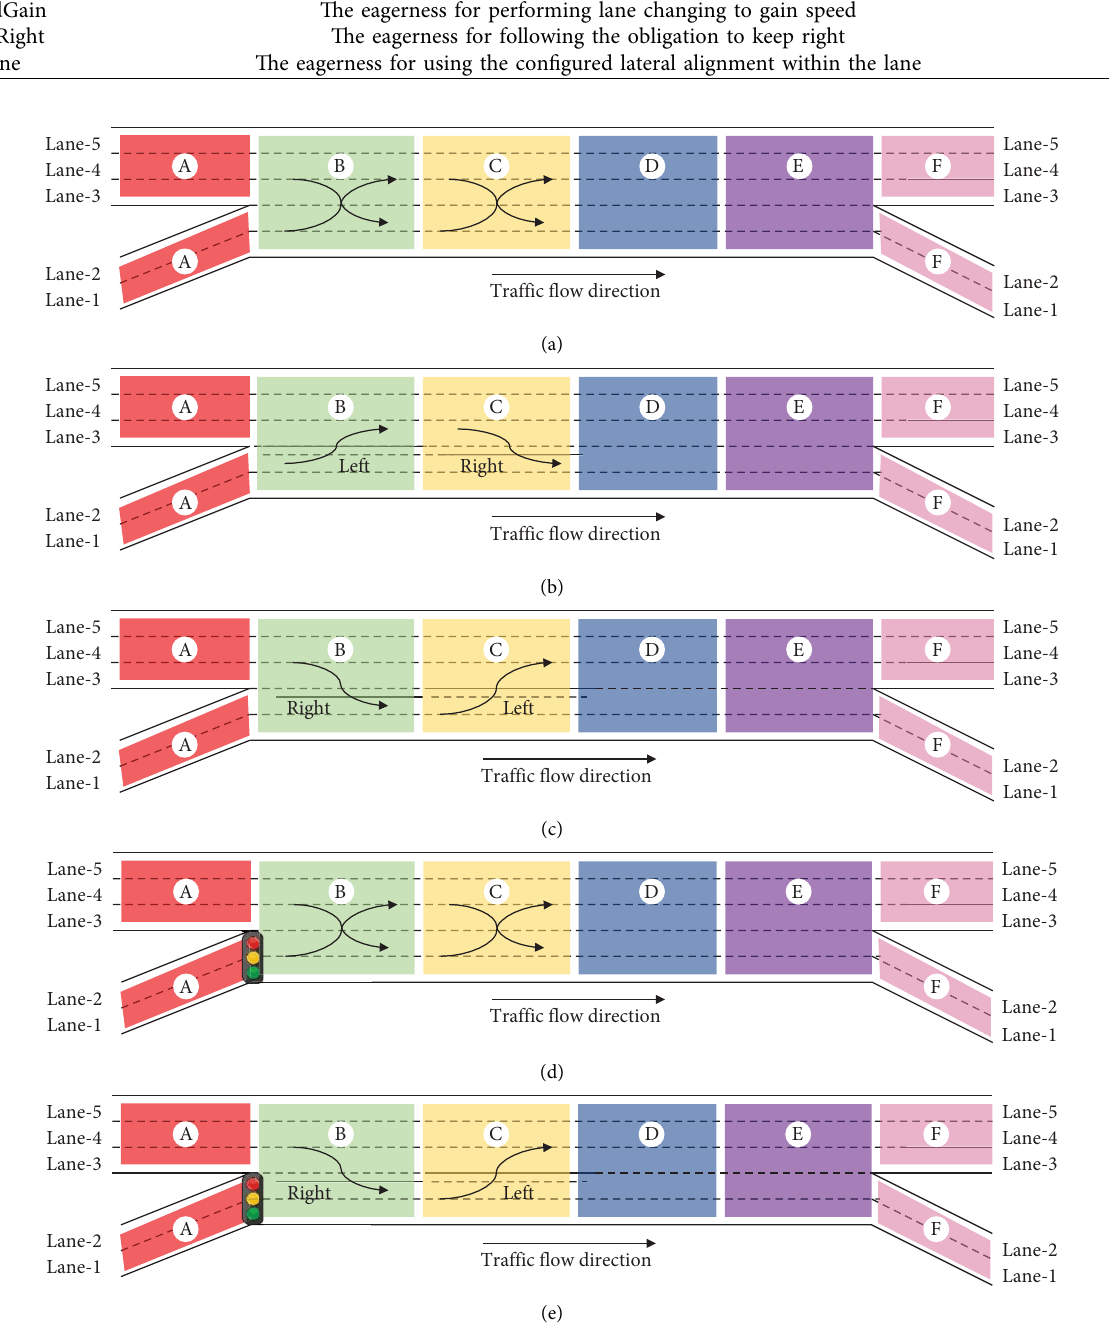
Figure 6: Control strategies in the weaving area on the urban expressway. (a) Baseline: no controls. (b) Control-1 strategy: channelization left-right. (c) Control-2 strategy: channelization right-left. (d) Control-3 strategy: ramp metering. (e) Control-4 strategy: channelization and ramp